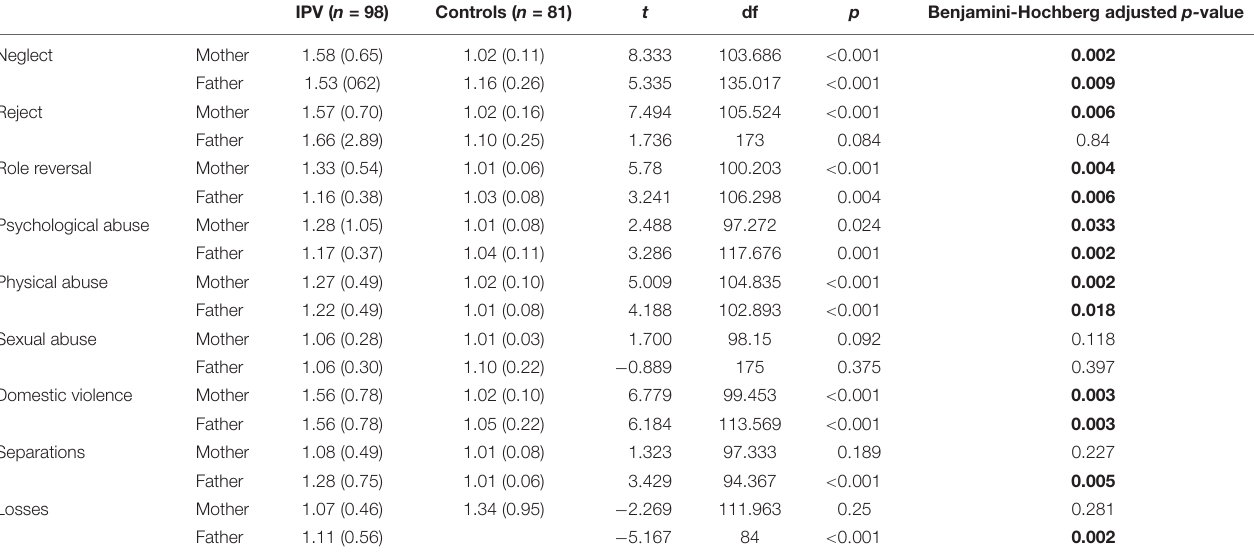
TABLE 8 | ComplexTQ scores in the IPV and control group.